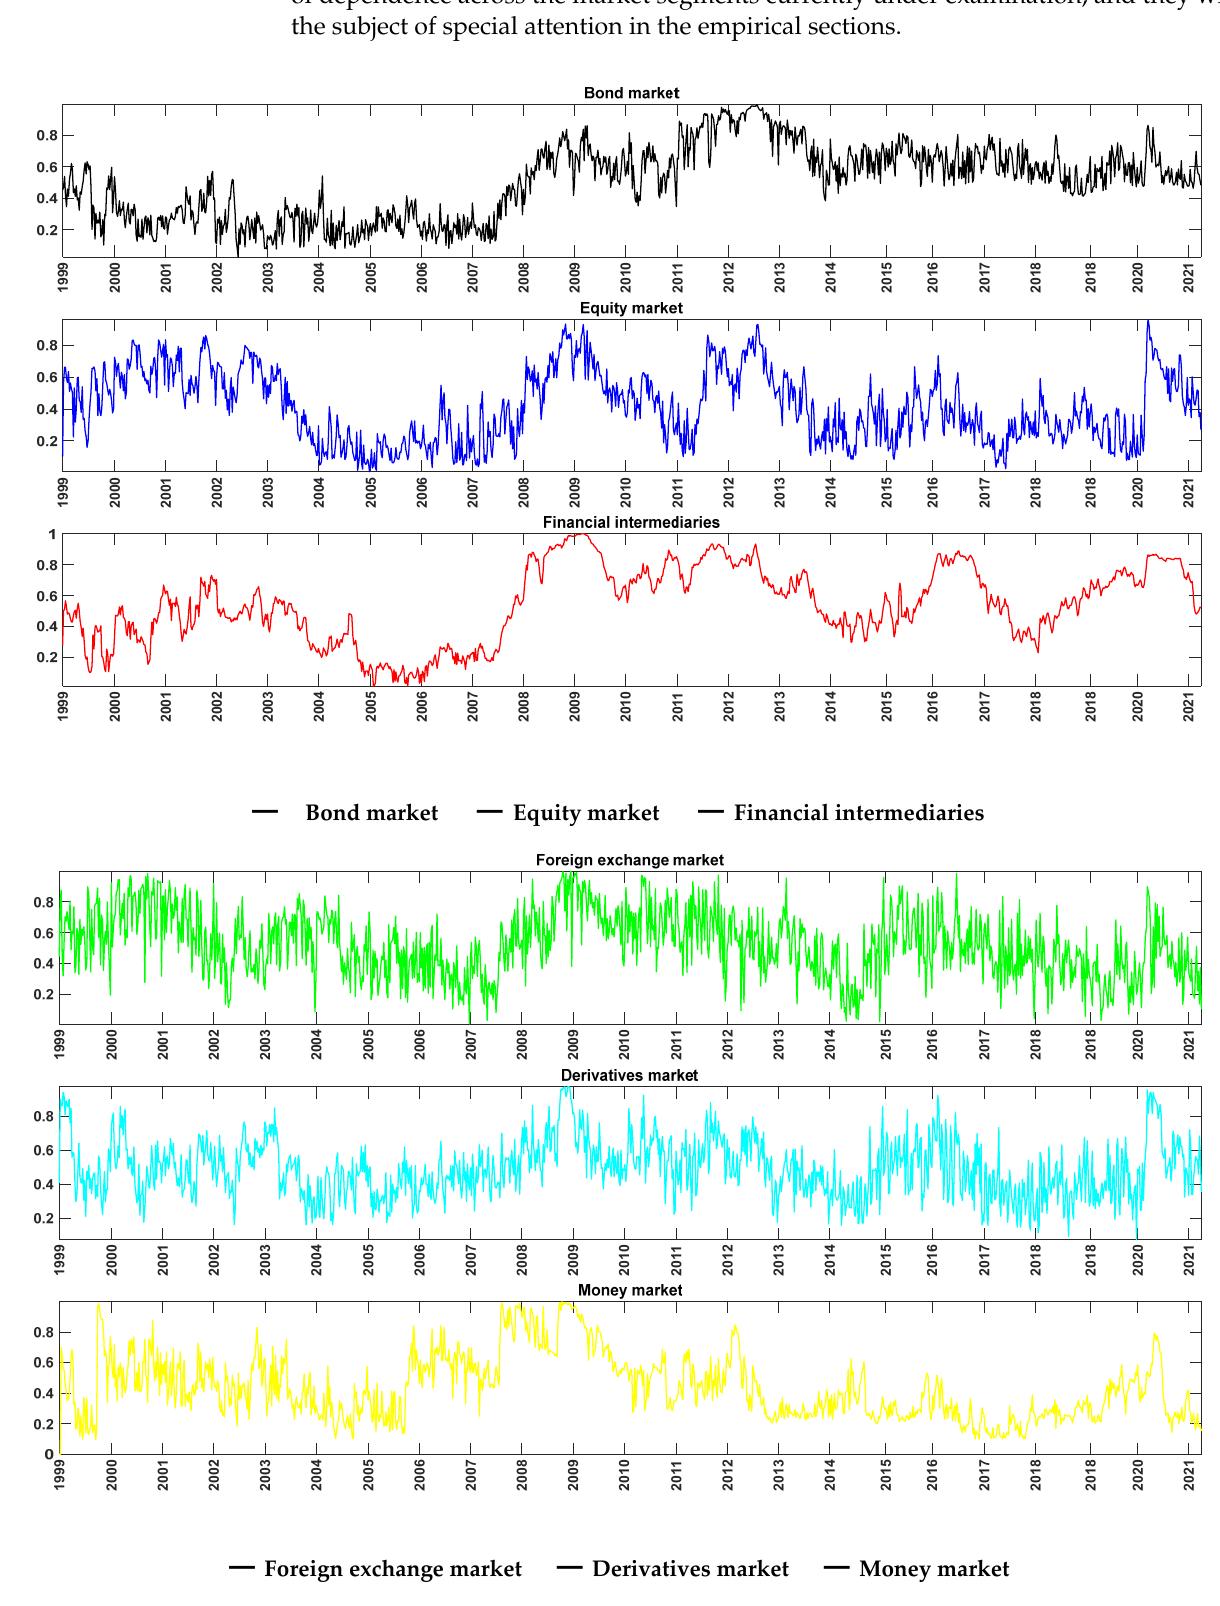
Figure 1. Stress indicators of the Spanish financial markets.